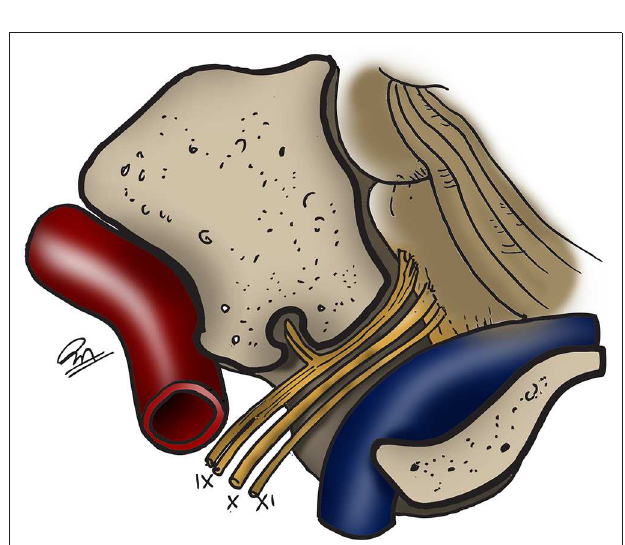
FIGURE 2 | Schematic view of the structures of the jugular foramen. Carotid artery in red, sigmoid sinus and jugular bulb in blue ( 3). IX: glossopharyngeal nerve. X, vagus nerve. XI, accessory nerve. [Modified from Ramina and Tatagiba ( 3)].